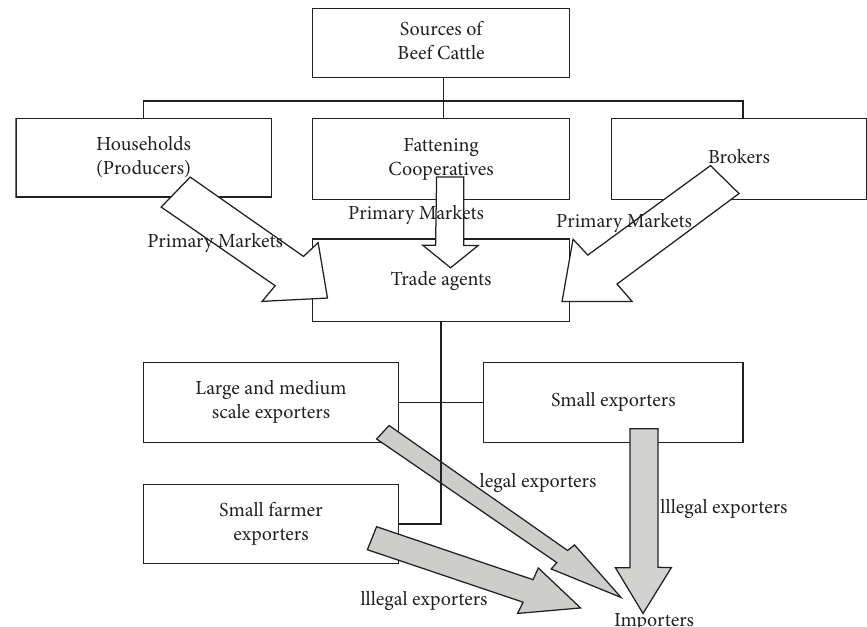
Figure 3: Beef cattle sources and market channel of trade in Ethiopia. Source: